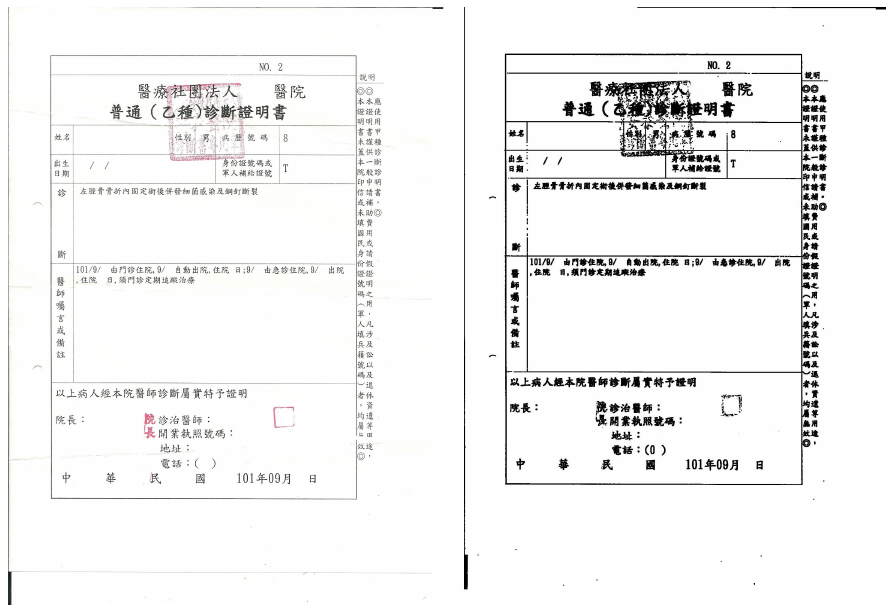
Figure 4. Data pre-processing.